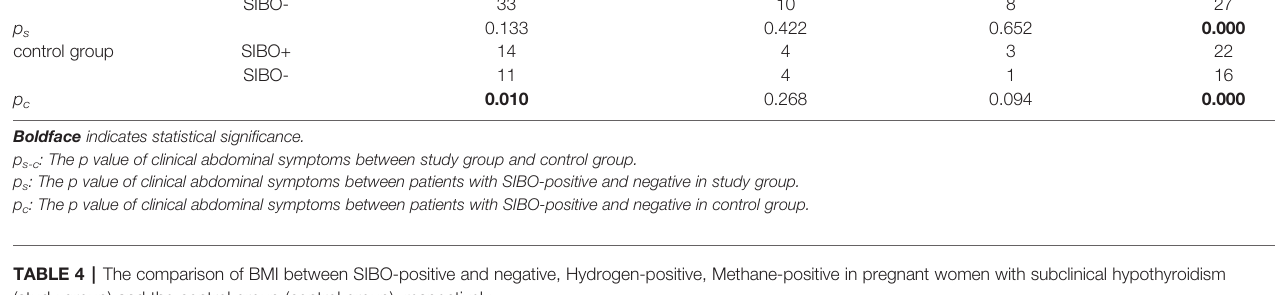
TABLE 4 | The comparison of BMI between SIBO-positive and negative, Hydrogen-positive, Methane-positive in pregnant women with subclinical hypothyroidism (study group) and the control group (control group), respectively. Group SIBO+ SIBO-